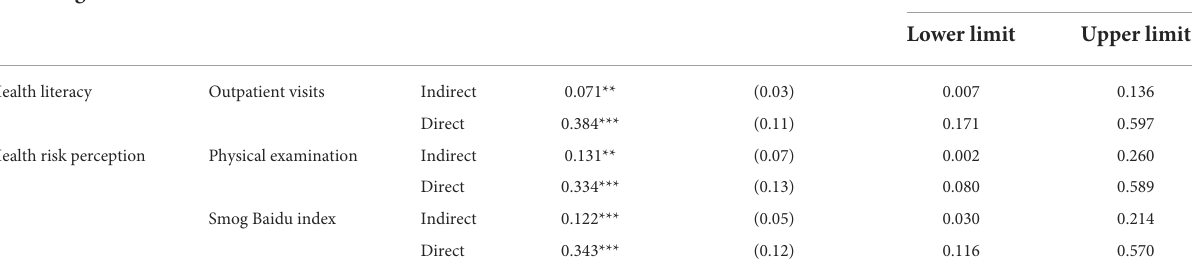
TABLE 5 The result of the mediating effect